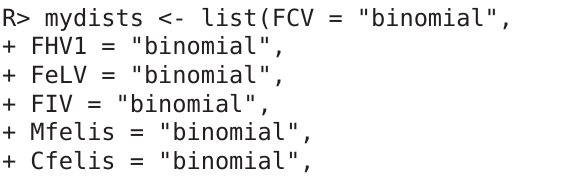
Poisson , and multinomial , where the last distribution is available with MLE scores